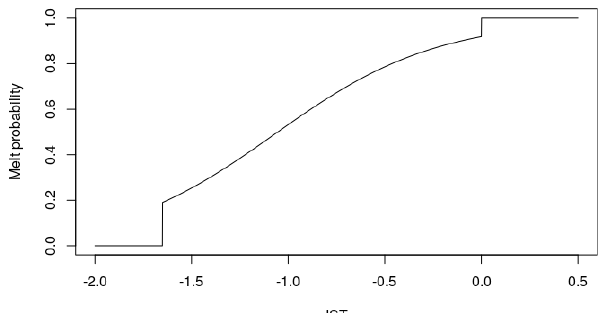
Figure 4. Melt probability estimates of a range of ISTs using the fit- ted mixture model at a single cell (75.37, − 58.13) on the Greenland ice sheet between 2001 and 2019. Because some cells have very limited data above − 1 . 65 ◦ C, we use a cell on the west coast with a high proportion of data above − 1 . 65 ◦ C (22 . 55%), thus giving us an increased amount of information in the most pertinent temperature